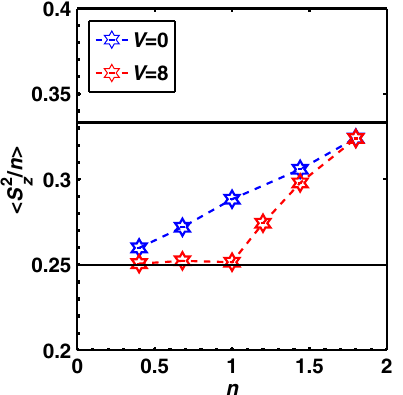
FIG. 14. The QMC results for the normalized on-site spin =n at β ¼ 6 , J ¼ 2 , and L ¼ 30 . Values of V are moment h S 2 z i marked in the inset.